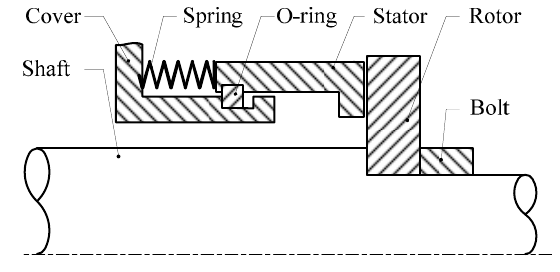
Fig. 3 Diagram of the non-contact mechanical seal.